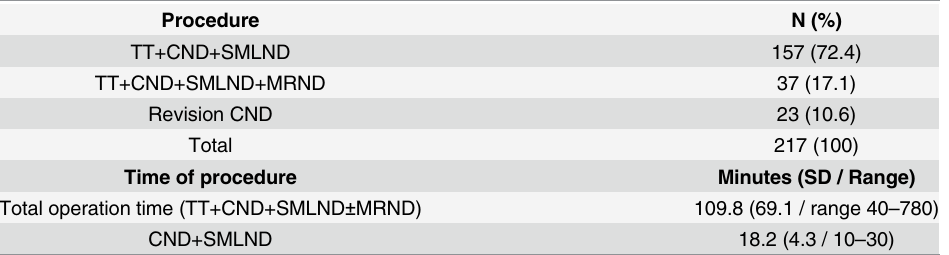
Table 1. Demographic information. TT; total thyroidectomy, CND; central compartment neck dissection, SMLND; superior mediastinal lymph node dissection, MRND; modified radical neck dissection.